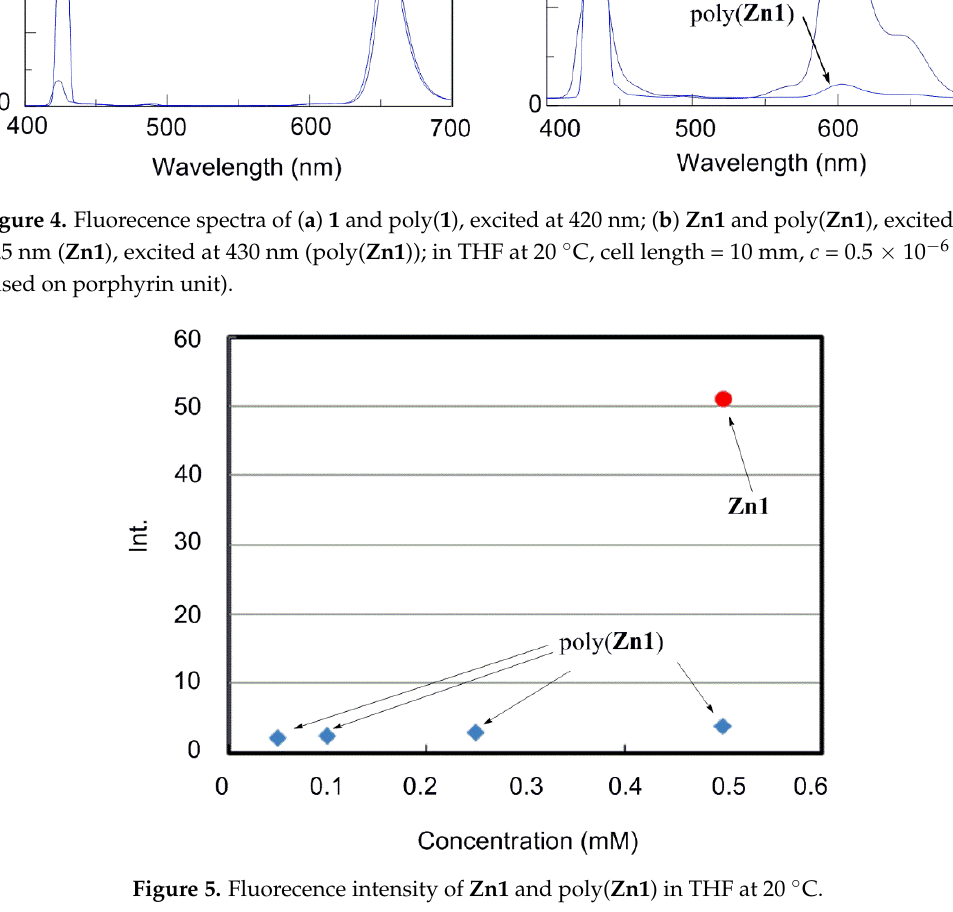
Figure 5 . Fluorecence intensity of Zn1 and poly( Zn1 ) in THF at 20 o C. Figure 5. Fluorecence intensity of Zn1 and poly( Zn1 ) in THF at 20